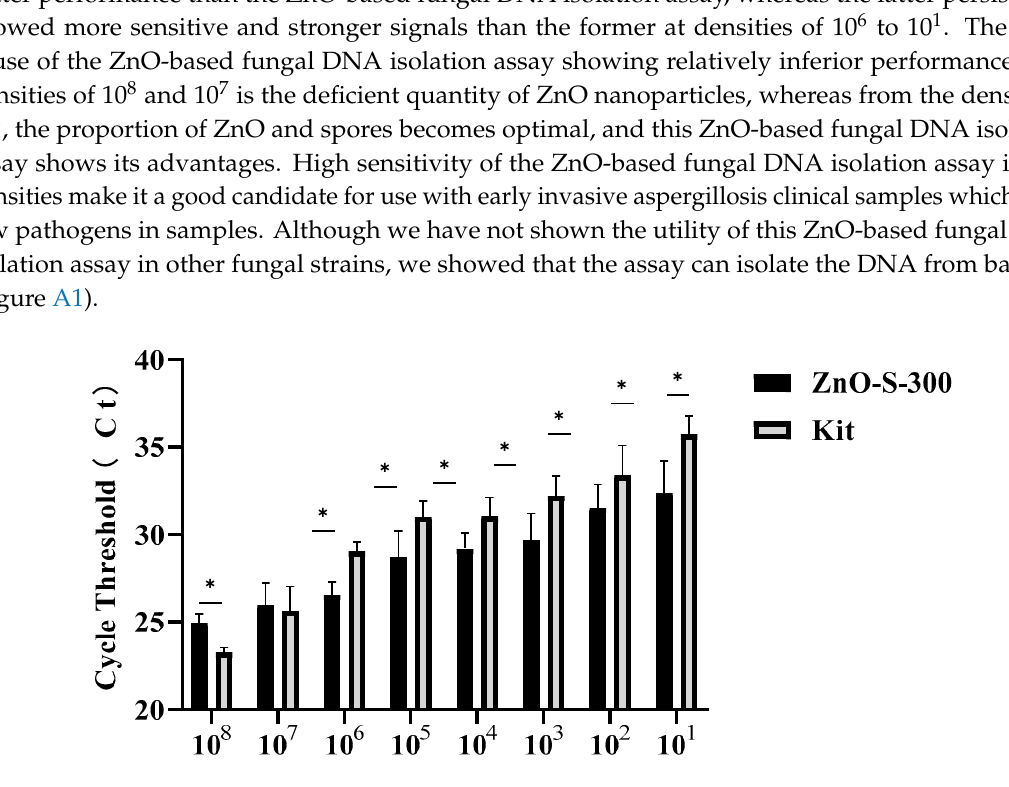
8 of 11 Figure 3. Optimization of the work conditions for ZnO nanoparticle synthesis in the ZnO extraction method. ( A ) SEM images of commercial nanoparticles ZnO-C-100. ( B ) SEM images of synthesized nanoparticles ZnO-S-300, ( C ) SEM images of commercial nanoparticles ZnO-C-5000. ( D , E ) Performance evaluation of the ZnO lysis buffer DNA extraction method using the synthesized ZnO (~300 nm, ZnO-S-300) nanomaterial at three different incubation temperatures ( D ) and times ( E ) by